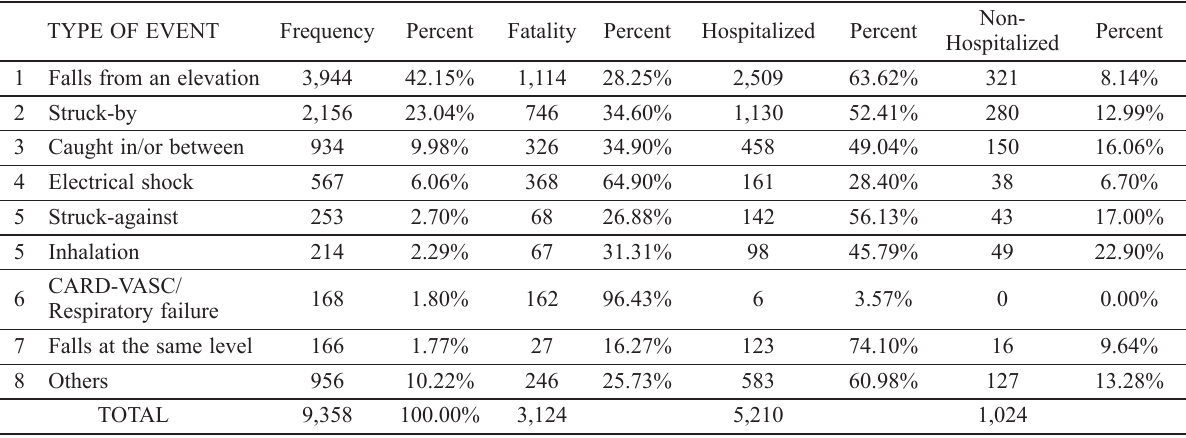
Table 1. Frequency of each accident type and its injury distribution TYPE OF